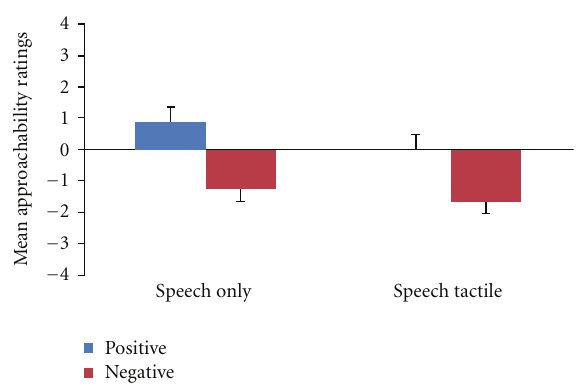
Figure 5: Means and SEMs for the ratings of the stimulus approachability.